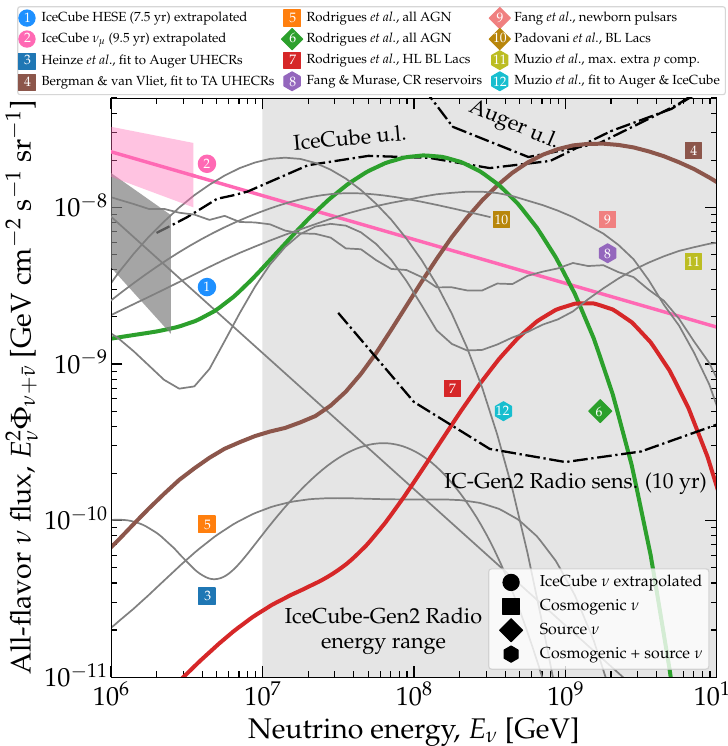
Figure 5 . Benchmark UHE neutrino flux models used in our analysis [29, 54–62]. Highlighted models 2, 4, 6, and 7 receive special attention in the main text, but results for all models are shown in tables 1 and 2, and in appendix A. The upper limits on the UHE neutrino flux are from IceCube [32] and the Pierre Auger Observatory [33]. The projected sensitivity of the radio component of IceCube-Gen2 is from ref. [43]. See section 4 for an overview of the flux